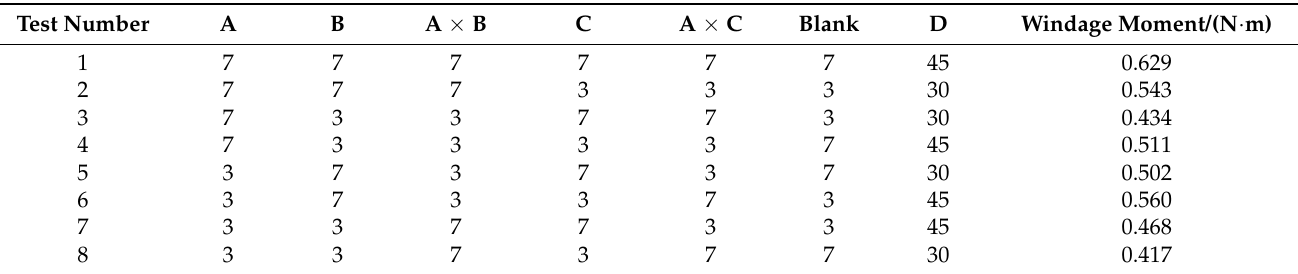
Table 5. Orthogonal table of simulation analysis results.